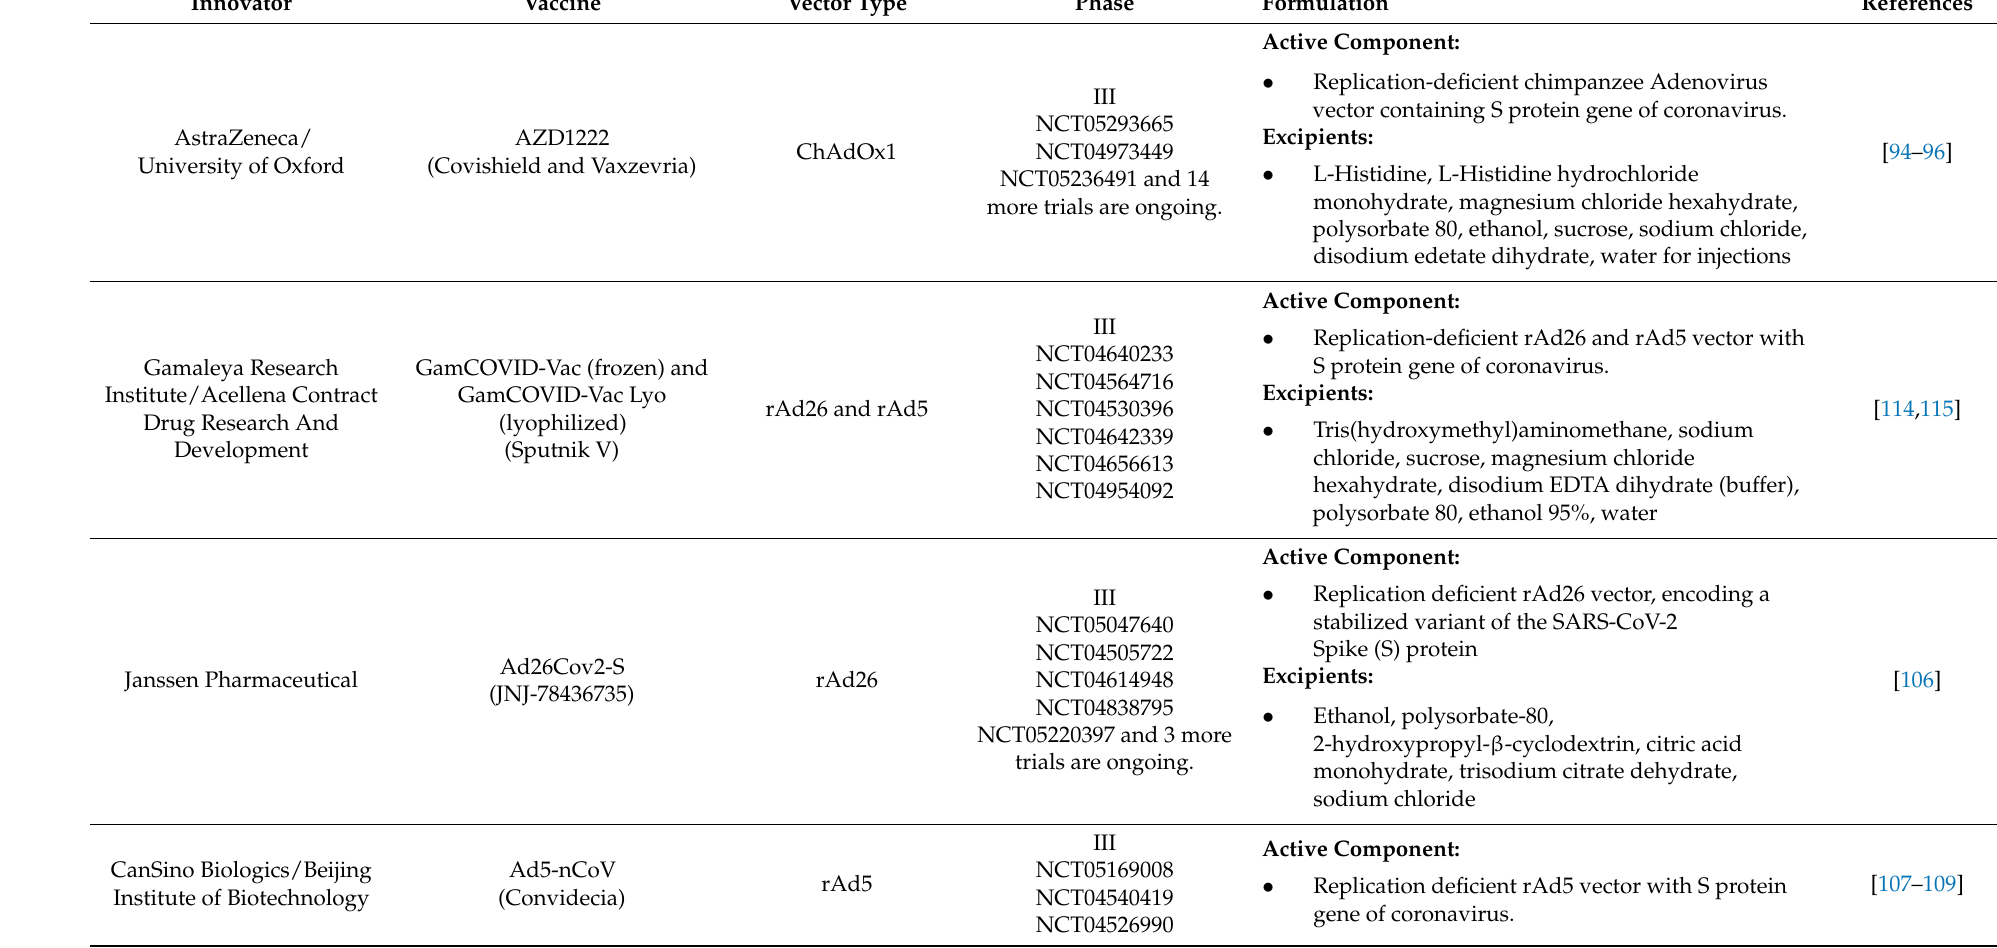
Table 1. EUA-licensed adenoviral vector-based vaccines for COVID-19 via intramuscular route. Innovator Vaccine Vector Type Phase Formulation